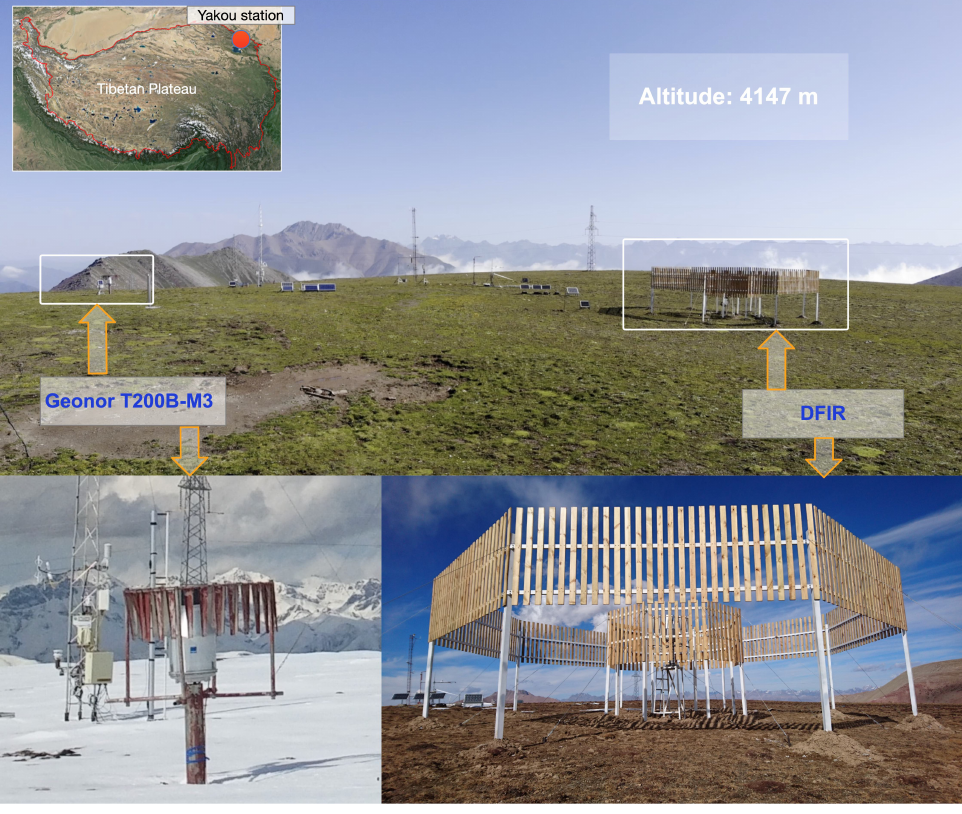
Figure 1. The Yakou station map. The figure shows the location of the Yakou station at the Tibetan plateau (the red dot), the relative positions, and close-up photos of the precipitation instruments (the T200B and